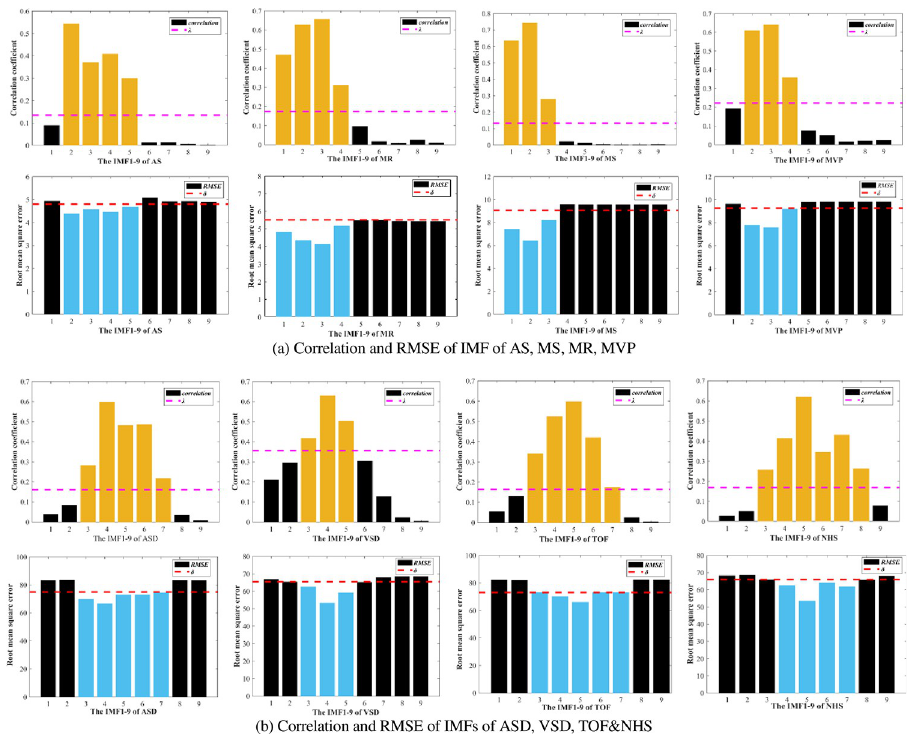
Fig 6. Correlation and RMSE of IMFs of heart sound. (a) Correlation and RMSE of IMF of AS, MS, MR, MVP; (b) Correlation and RMSE of IMFs of ASD, VSD,